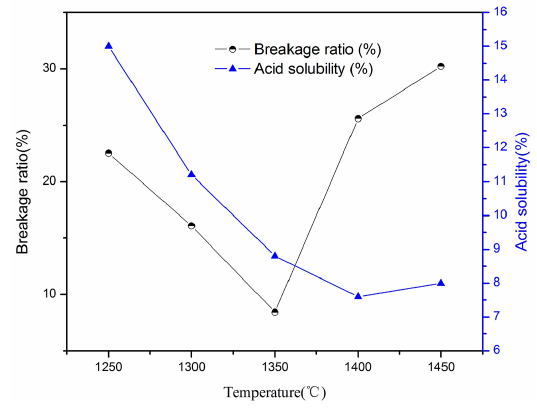
Figure 5. Breakage ratio at 52 MPa pressure and acid solubility with sintering